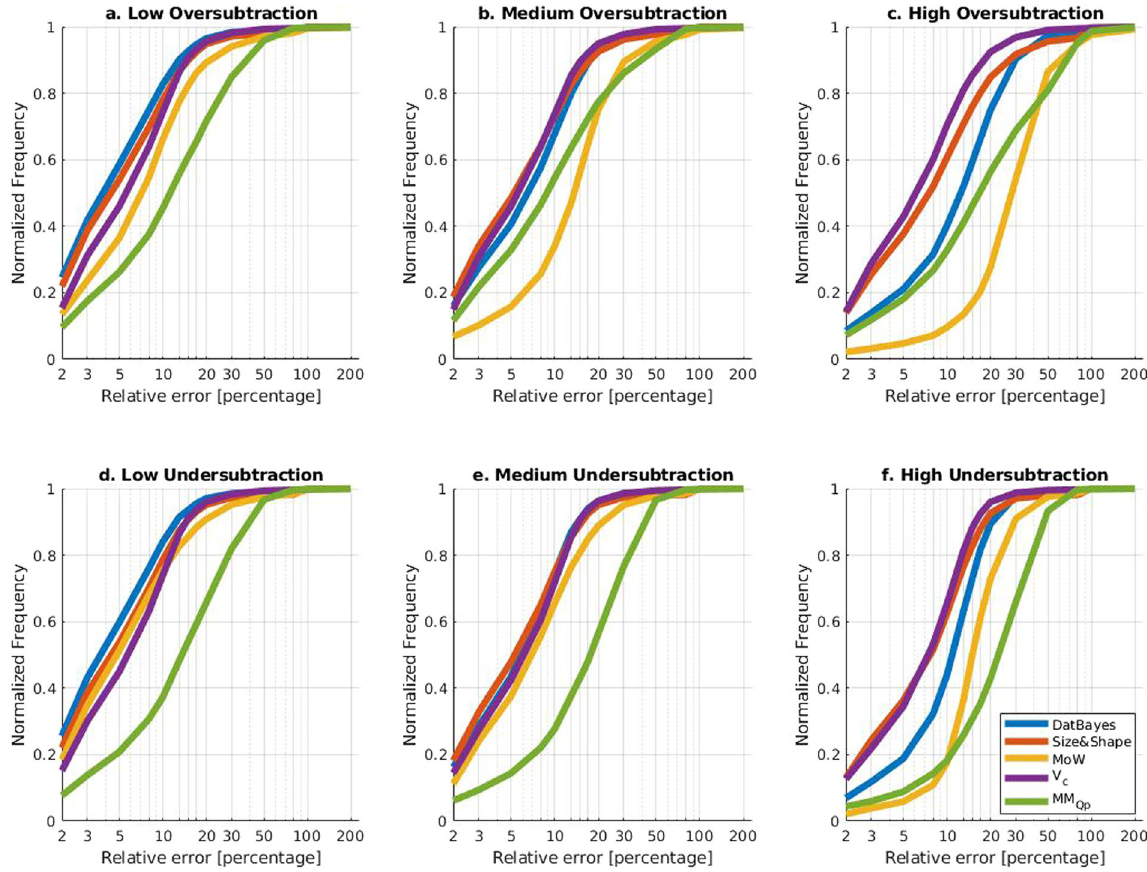
Figure 6. ROC-like curves of different levels of simulated systematic noise. ROC-like curves of relative error against normalized frequency for three different levels of under and over subtraction. The x-axis is log-scaled to better discern the performance Additional levels of over and under-subtraction were investigated (data not shown). Low, medium and high refers to factors of 0.1, 0.4 and 0.9 respectively (see